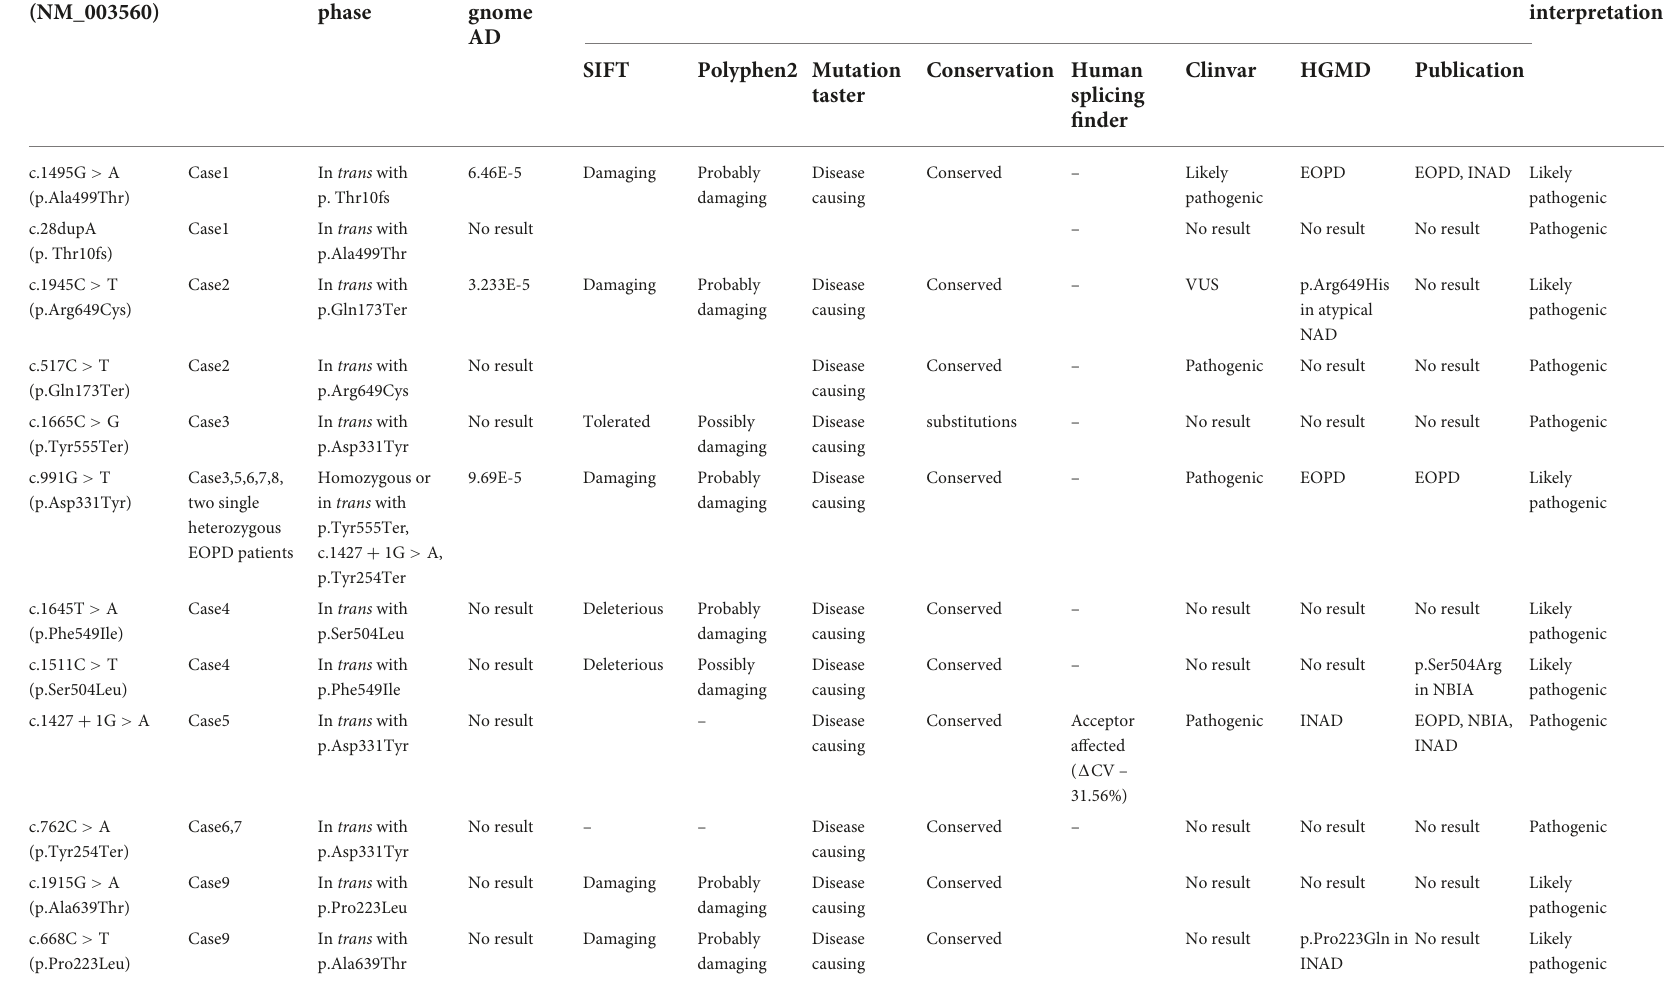
TABLE 1 Evaluation of mutations discovered in the PLA2G6